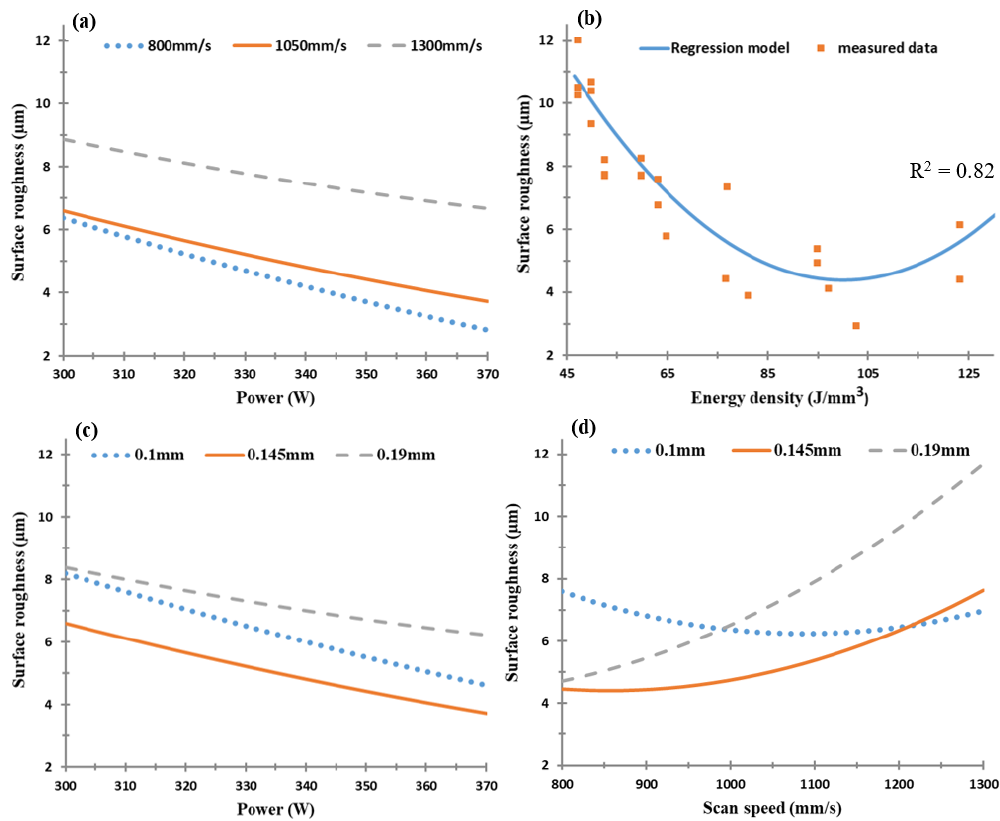
7 Figure 13. Surface roughness of the as-built Al6061 samples vs. ( a ) laser power (W), ( b ) energy density (J/mm 3 ), ( c ) hatch spacing (mm), and ( d ) scan speed